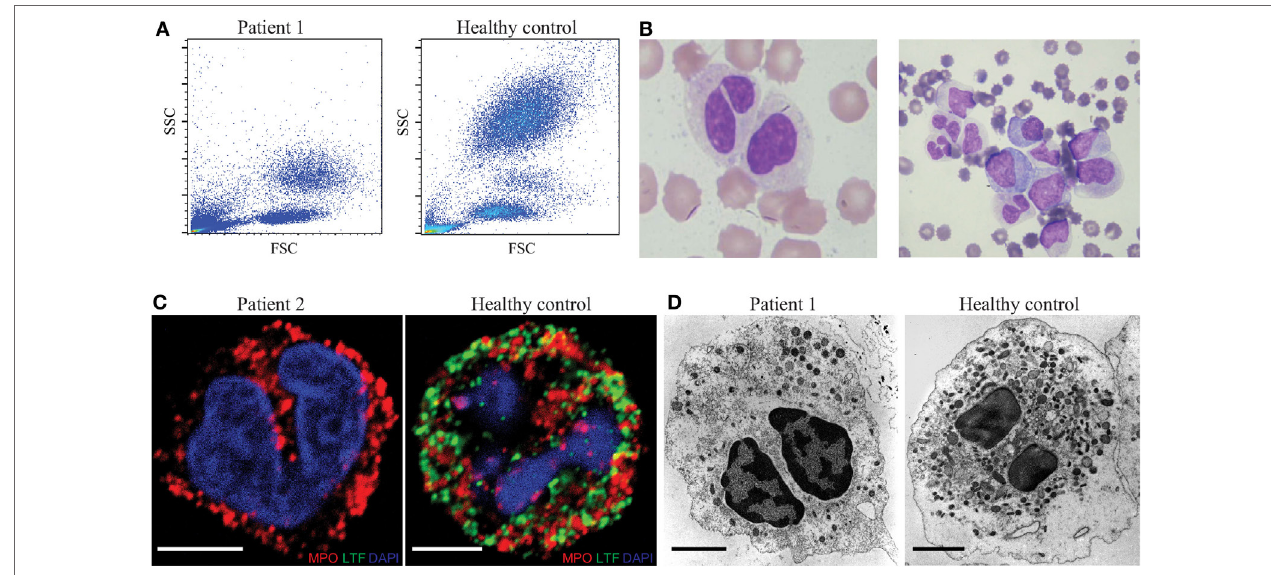
FigUre 1 | Characteristic aberrations in neutrophil granulocytes from patients with specific granule deficiency. (a) Forward/sideward scatter of whole blood after erythrocyte lysis. (B) Hematoxylin/eosin staining of peripheral blood smear (left) and bone marrow aspirate (right) of the patient. (c) Immunofluorescence analysis of myeloperoxidase (MPO, red) and lactoferrin (LTF, green) in the neutrophils of patient (left) and healthy donor (right), scale bar: 5 µm. (D) Analysis of patient (left) and healthy control (right) neutrophils in transmission electron microscopy; scale bar: 2